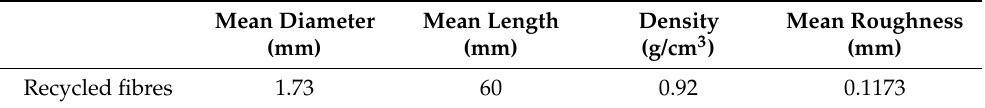
Table 3. Recycled fibre general properties.